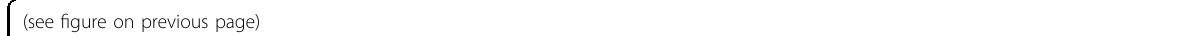
Fig. 1 SIRT2 functions as an eraser of histone lactylation in neuroblastoma cells and increased histone lactylation promote cell proliferation and migration. a Schematic illustration of screening for the delactylase activity of sirtuins using a fl uorescence probe. In the probe, NBD is covalently linked to an oxygen atom; when the lactyl group is removed (for example by some tested sirtuin proteins), the free amine group of lysine residue attacks the O-linked NBD group, and covalent linkage of the NBD group with a nitrogen atom turns on the fl uorescence signal. The lactyl group is colored blue. The O-NBD group is indicated by a red circle. The N-NBD is colored green to indicate the fl uorescence signal and is marked by a green circle. b Fluorescence assay of the probe with the indicated sirtuin proteins ( λ ex = 480 nm, λ em = 545 nm). c Fluorescence assay of the probe with SIRT2 ( λ ex = 480 nm, λ em = 545 nm) in the presence of the inhibitor Tenovin-6 (500 μ M). d Michaelis-Menten plots for SIRT2 against the four peptides bearing H2AK115la, H2BK85la, H3K18la, or H4K91la modi fi cations, respectively. The sequence of the peptides and kinetic parameters K m , K cat , and K cat /K m are shown in the tables. e Pan and histone lactylation levels at the H3K14, H3K18, H4K8, and H4K12 sites in SIRT2 knockdown (KD) SH-SY5Y cells, as detected by immunoblotting. f Cell proliferation rate of SIRT2 KD cells was signi fi cantly increased, as measured using a BrdU assay (chemiluminescent). g Cell migration capacity of SIRT2 KD cells was signi fi cantly increased, as evaluated using Transwell assays. The number of stained cells which migrated to the lower chamber was counted using ImageJ. h Histone lactylation levels at the H4K8 site in SH-SY5Y cells upon lactate treatment, as detected by immunoblotting. i Cell proliferation rate of SH-SY5Y cells was signi fi cantly increased upon lactate treatment, as measured using a BrdU assay (chemiluminescent). j Intracellular lactate concentration of control or SIRT2 KD SH-SY5Y cells upon LDHA inhibitor gne140 treatment (10 μ M), as detected by ELISA. k Histone lactylation levels at H4K8 site in control or SIRT2 KD cells upon LDHA inhibitor gen140 treatment (10 μ M), as detected by immunoblotting. l Cell proliferation rate of control or SIRT2 KD cells upon LDHA inhibitor gen140 treatment (10 μ M), as measured using a BrdU assay (chemiluminescent). m ChIP was performed with an anti-H4K8la antibody in control and SIRT2 KD cells. qPCR analysis of the ChIP precipitates was performed to assess the occupancy of H4K8la marks at the promoters of SERPING1 and TRPV4 genes shown to regulate tumor cell proliferation and migration. n qPCR analysis of SERPING1 and TRPV4 expression in control and SIRT2 KD cells. o , p The protein levels of SIRT2 ( o ) and SERPING1 ( p ) were quanti fi ed by mass spectrometry, and Kaplan – Meier (K-M) analysis of their levels with overall survival (OS) was conducted using the R package “ survival ” . The optimal cut-off value of each protein for the K-M plots was calculated using the “ survminer ” package. The SIRT2 KD cell line in the present fi gure refers to the SIRT2 KD-1 cell line in Supplementary Fig. S3. The complete data sets of SIRT2 KD cell lines with two shRNA are presented in Supplementary Fig. S3. The relative intensity of each band was quanti fi ed via densitometry, using ImageJ after normalization to β -actin, with the values expressed as the fold change versus the value detected for control SH-SY5Y cells. All data are presented as the means ± SEM, calculated from three independent experiments. * P < 0.05; ** P < 0.01; *** P < 0.001; **** P < 0.0001; n.s., not signi fi cant as calculated by two-tailed student ’ s t-